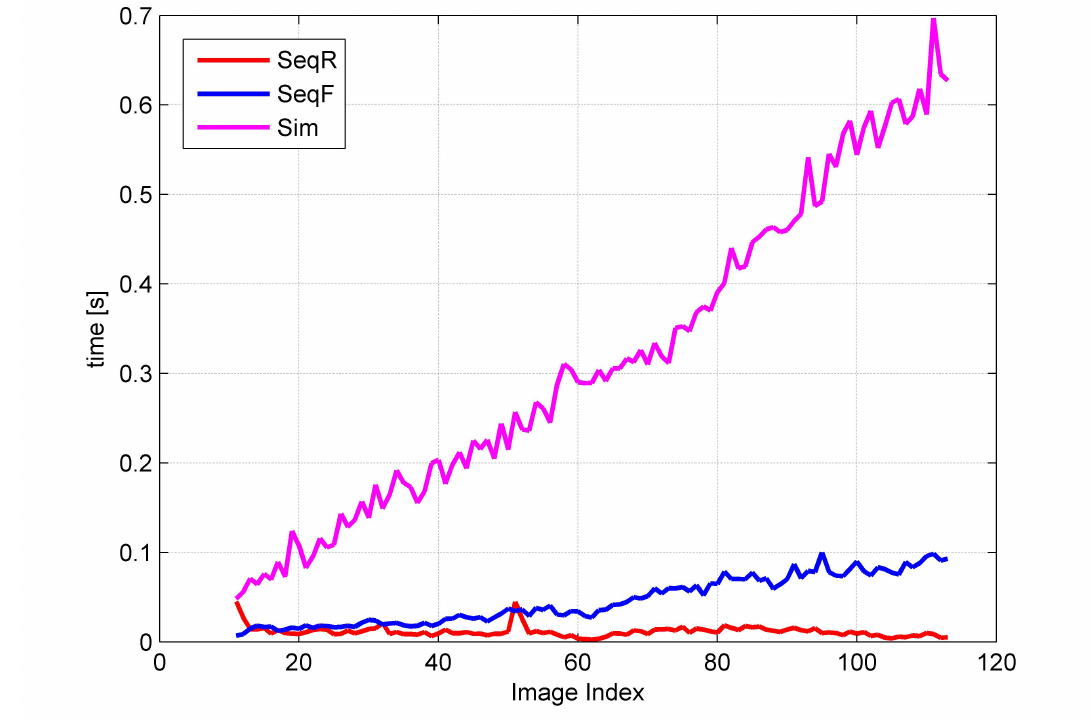
Figure 18. Processing time of each AT